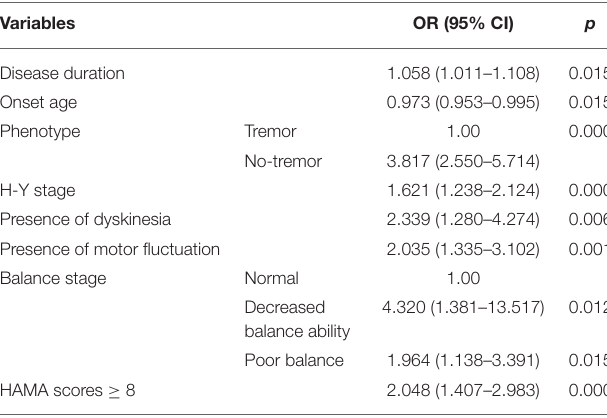
TABLE 2 | Clinical factors related to FOG in this